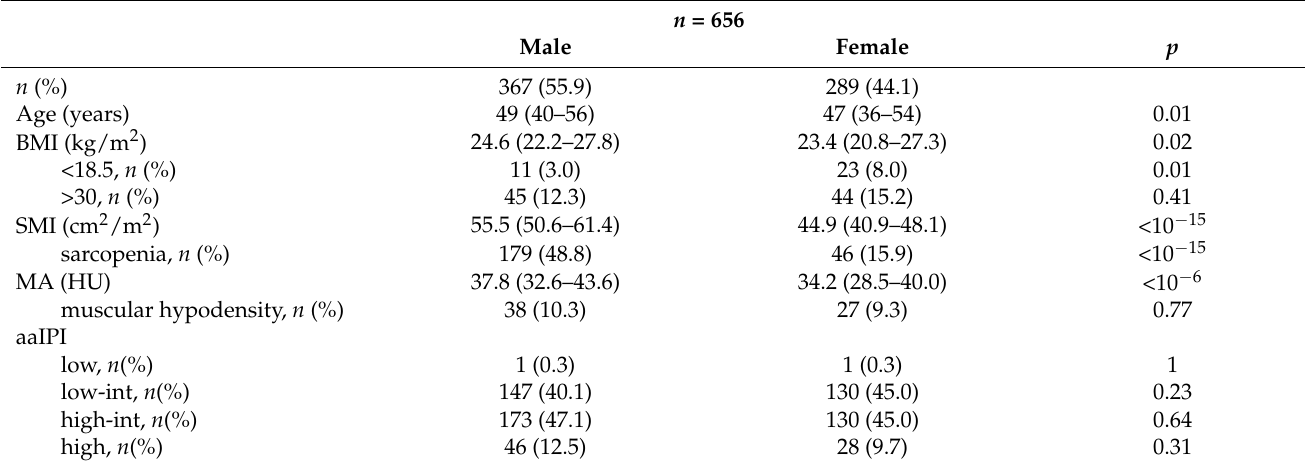
Table 2. Patient characteristics at